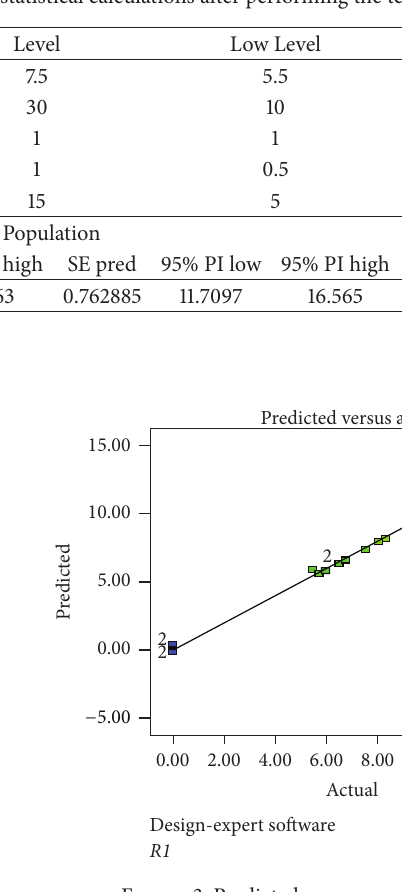
Figure 3: Predicted response versus actual